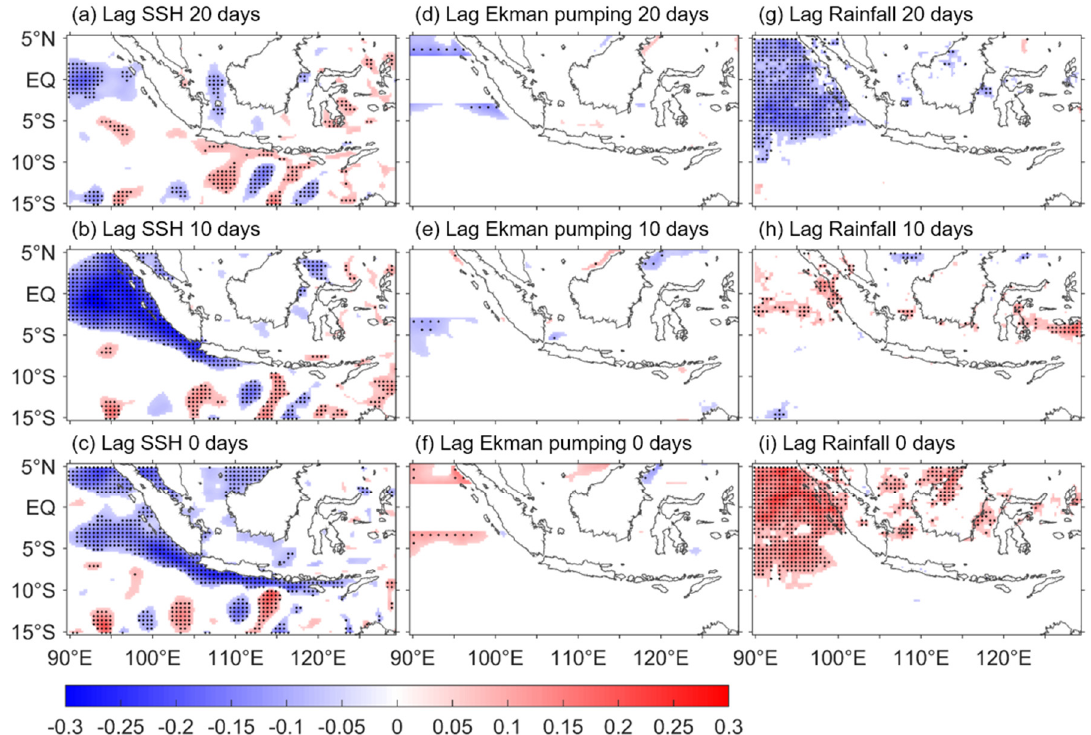
Figure 6. Correlations between the area averaged (Region A) intraseasonal SSC and the intraseasonal SSH with ( a ) 20 days lag; ( b ) 10 days lag; ( c ) 0 days lag; ( d – f ) same as ( a – c ) but correlated to Ekman pumping; ( g – i ) same as ( a – c ) but correlated to rainfall. The intraseasonal time series are extracted from raw data during the period of 1 January 1998 to 31 December 2019 by employing a 20–90-days bandpass filter.